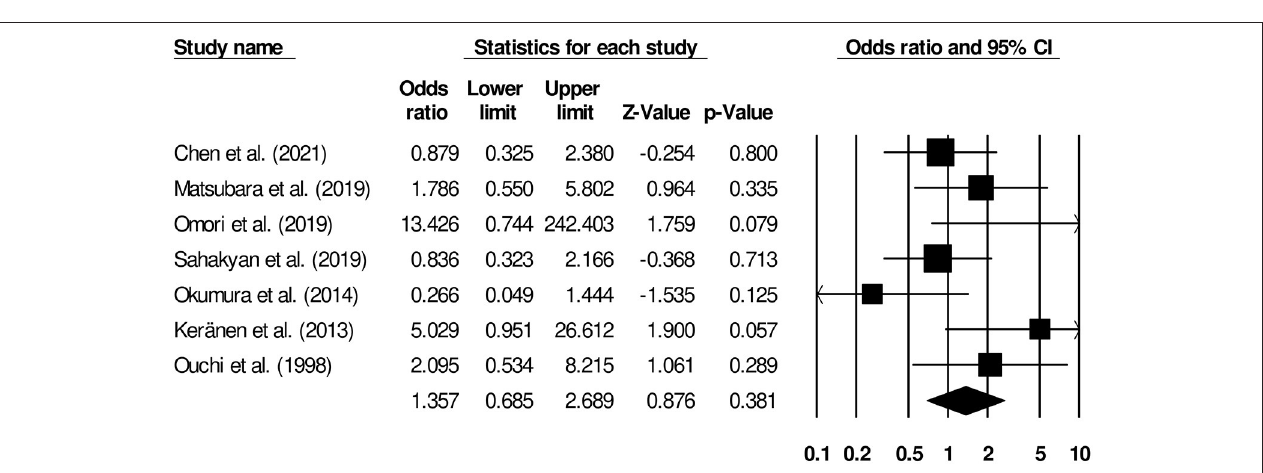
FIGURE 5 | Forest plot for studies comparing complication rates in patients undergoing gastrojejunostomy or palliative gastrectomy.